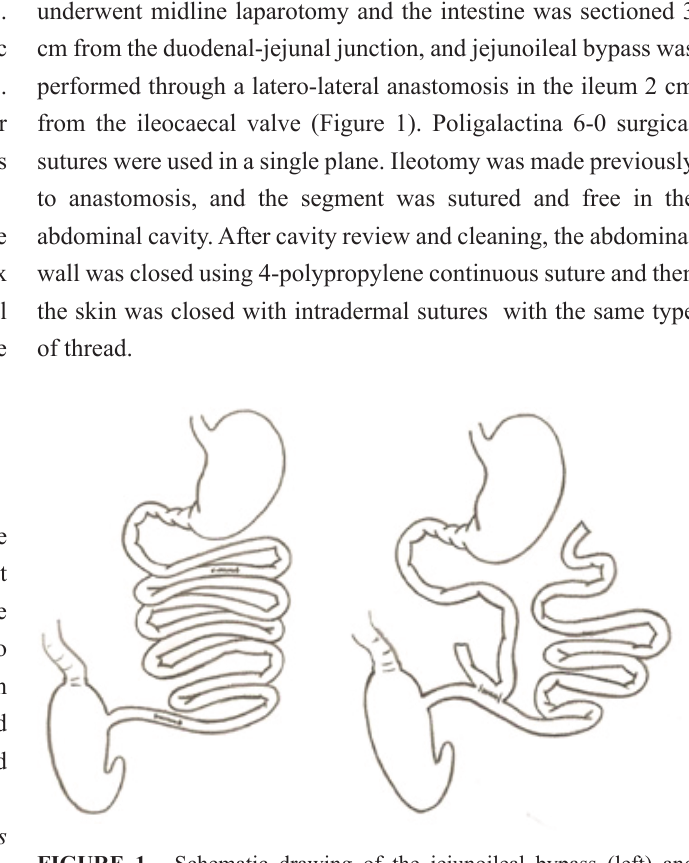
FIGURE 1 - Schematic drawing of the jejunoileal bypass (left) and anastomosis of the proximal jejunum to the ileum 2 cm from the ileocecal valve (right). Model proposed by Bristol et al . 5 .